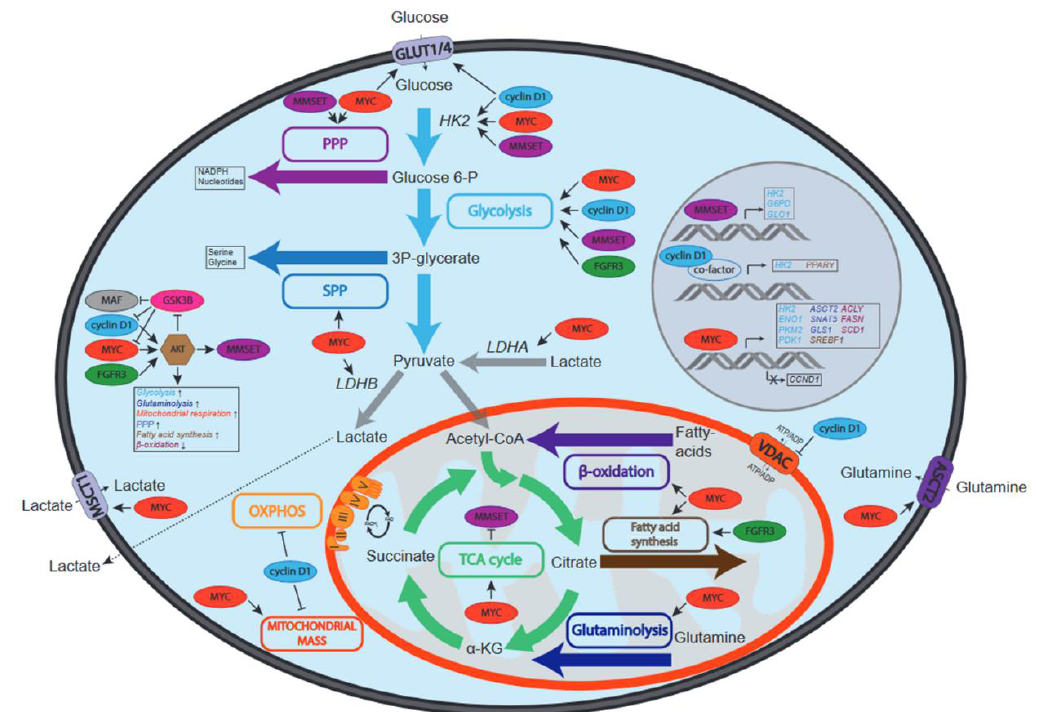
Figure 2. Schematic overview of the effects of recurrent genetic aberrations on metabolic pathways in MM. Depicted are MYC, cyclin D1, MMSET, FGFR3 and MAF and the effects they have on the activity of metabolic pathways (depicted by colored boxes and arrows) and/or metabolite transporters (MSCT1, VDAC, ASCT2, GLUT1 and GLUT4). Increased or decreased activation can be due to regulation of the activity, protein stability or expression of enzymes involved in specified pathways. In the middle left the effects of MYC, cyclin D1, MMSET, FGFR3 and MAF on AKT, a central regulator of metabolism, are depicted. Due to the key roles HK2, LDHA and LDHB play in glucose and lactate metabolism, the effects of oncogenes on these enzymes are also shown.